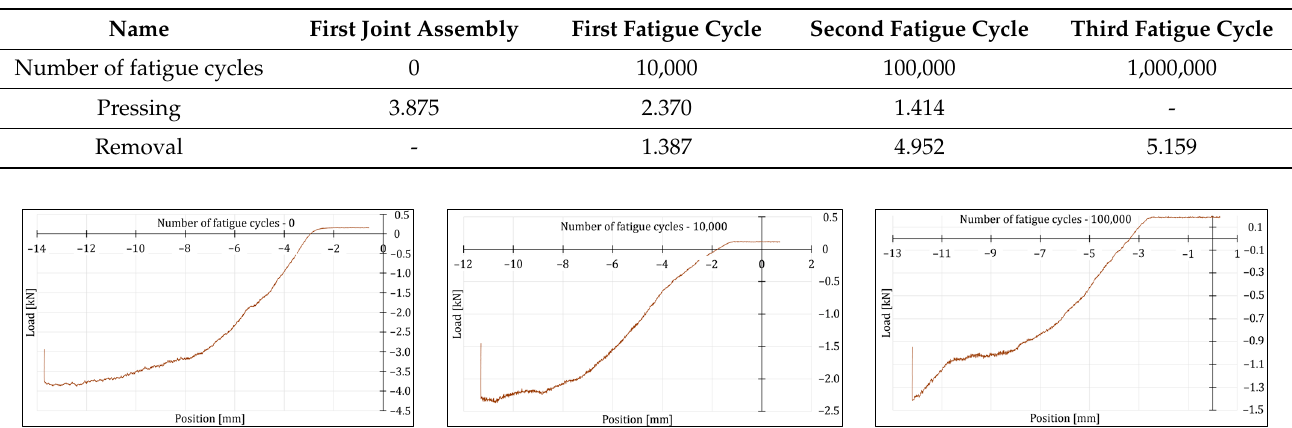
Figure 5. Shaft sleeve removal force pa tt ern after successive fatigue